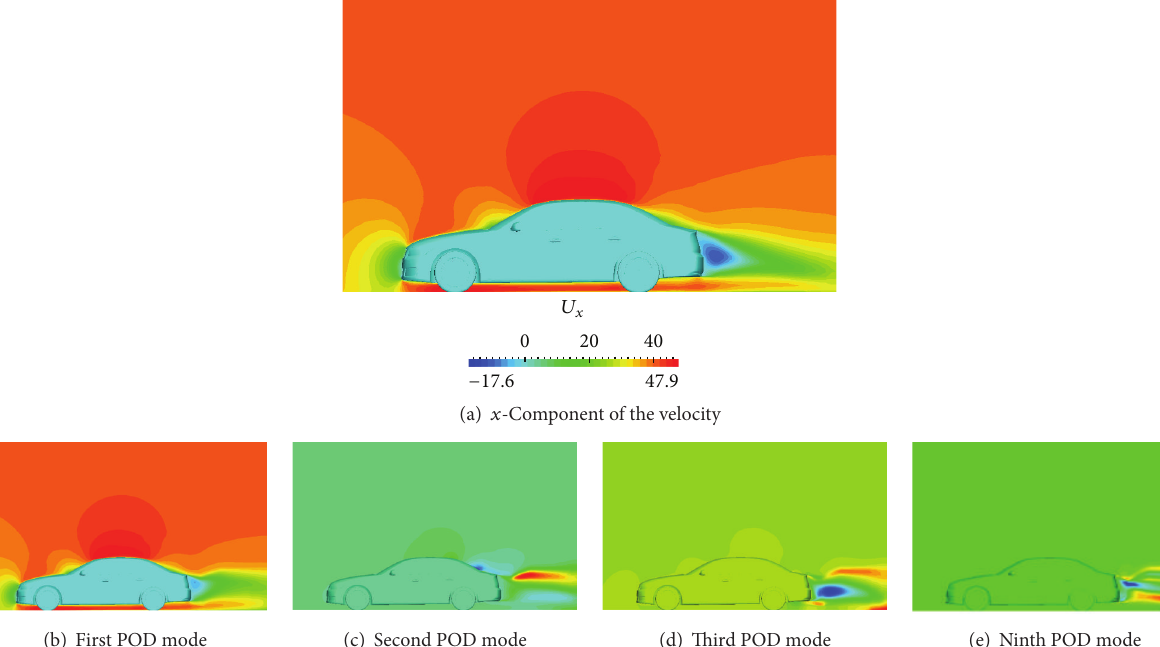
Figure 20: DrivAer model. Comparison between the velocity field obtained from the PODI surrogate model and the individual POD modes.